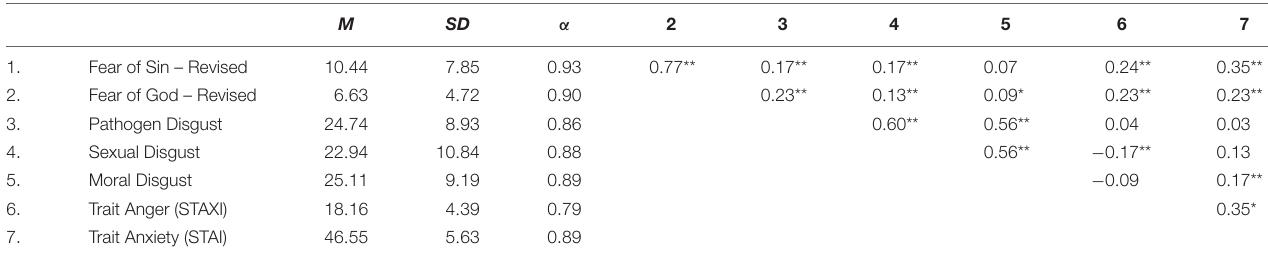
TABLE 1 | Means, standard deviations, alphas and correlations for all measures used in the study. M SD